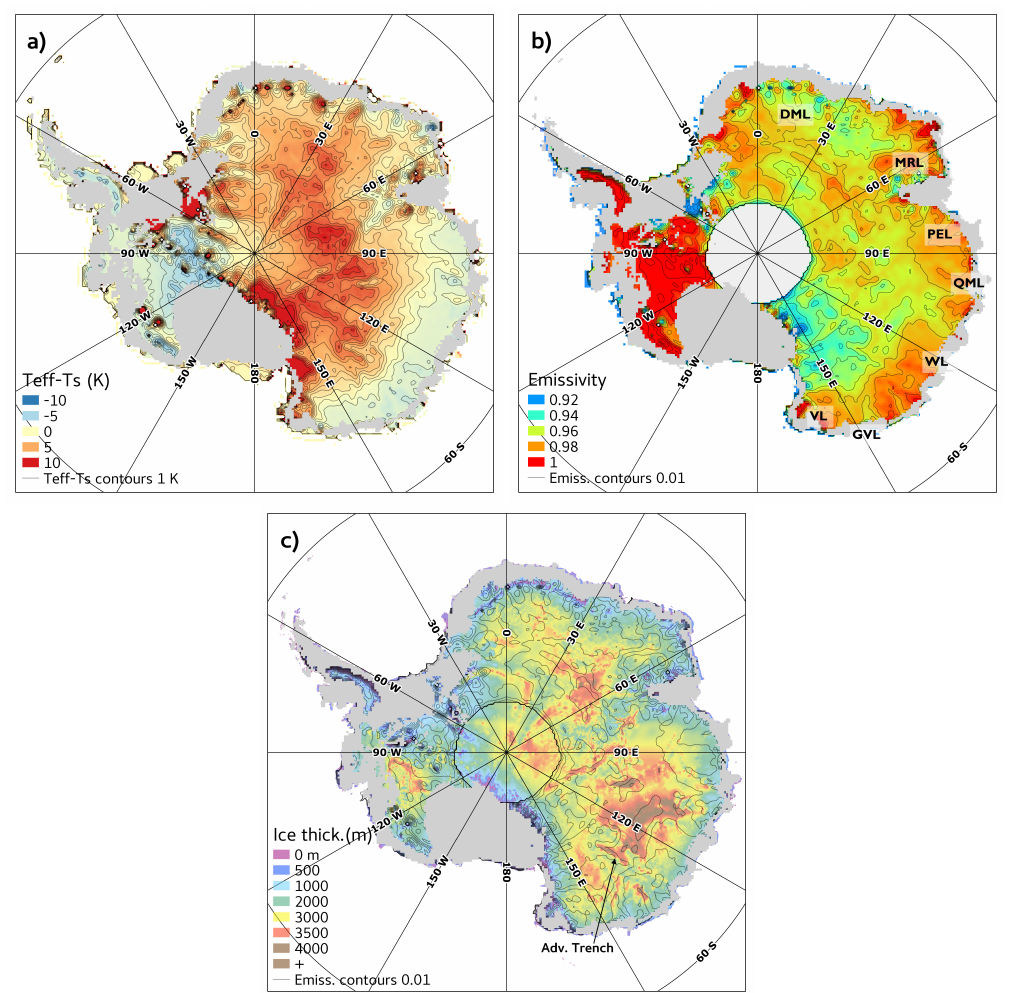
Figure 6. Areas undergoing more than five days of melt over the 1979–2007 time period are masked in grey and were not taken into account in the study. ( a ) Difference between T E and T s (K). Contour lines are 1K apart. ( b ) Emissivity spatial variations as computed from the Mätzler model. DML: Dronning Maud Land, MRL: MacRobertson Land, VL: Victoria Land, GVL: George V Land, PEL: Princess Elizabeth Land, QML: Queen Mary Land, WL: Wilkes Land. Contour lines are 1% apart. ( c ) Ice thickness (m) from Bedmap 2 [55]. Emissivity contour lines are